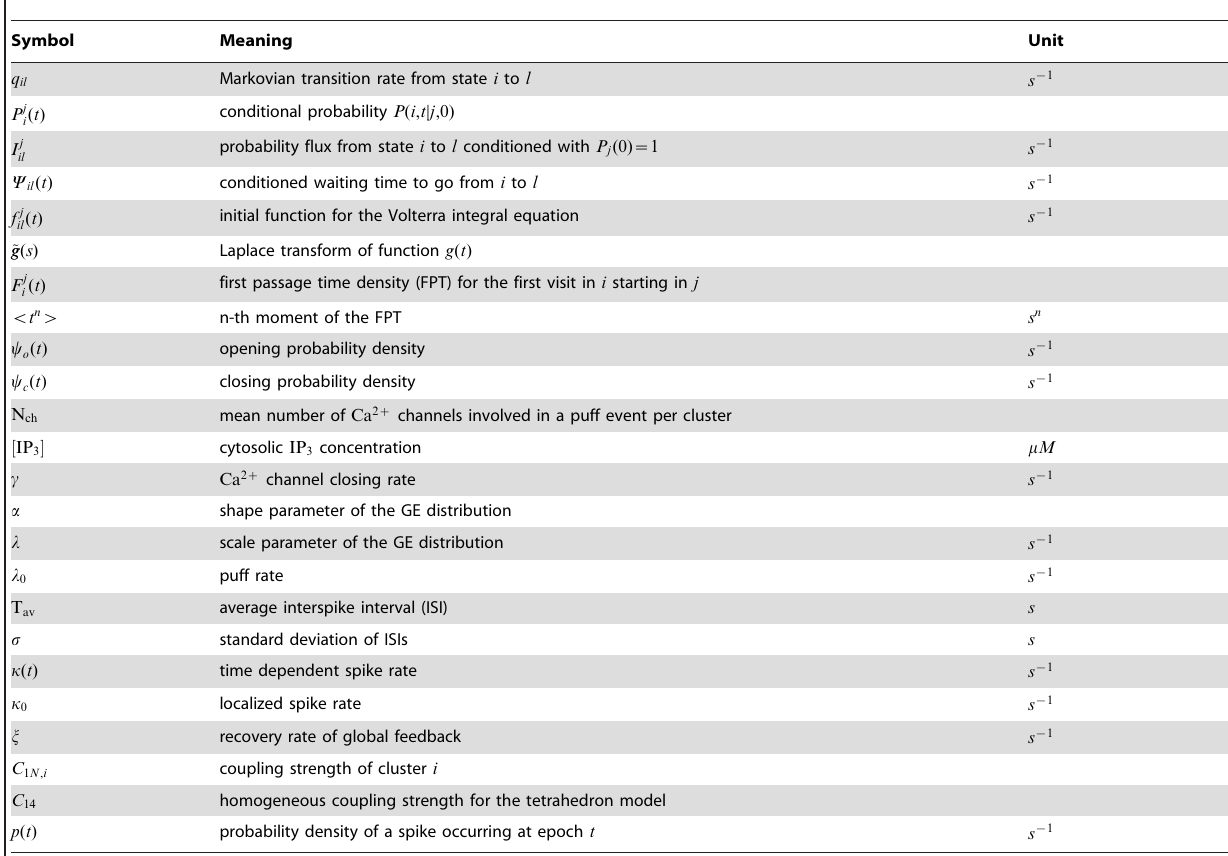
Table 1. Important mathematical symbols used in this work.